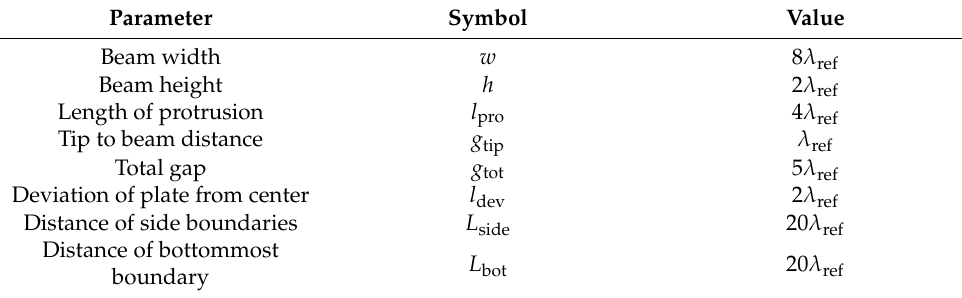
Table 1. Reference lengths for the physical domain. Parameter Symbol Beam width